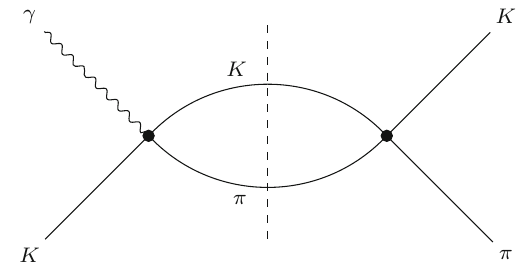
Fig. 4 Diagram of the s -channel contribution to γ K → K π ( i ) ( s ) reads relation for the P -waves f 1 ( s ) . Here, the partial waves with the K π P -wave amplitude t I 1 for i = 0 , 1 / 2 are both associated with I = 1 / 2,